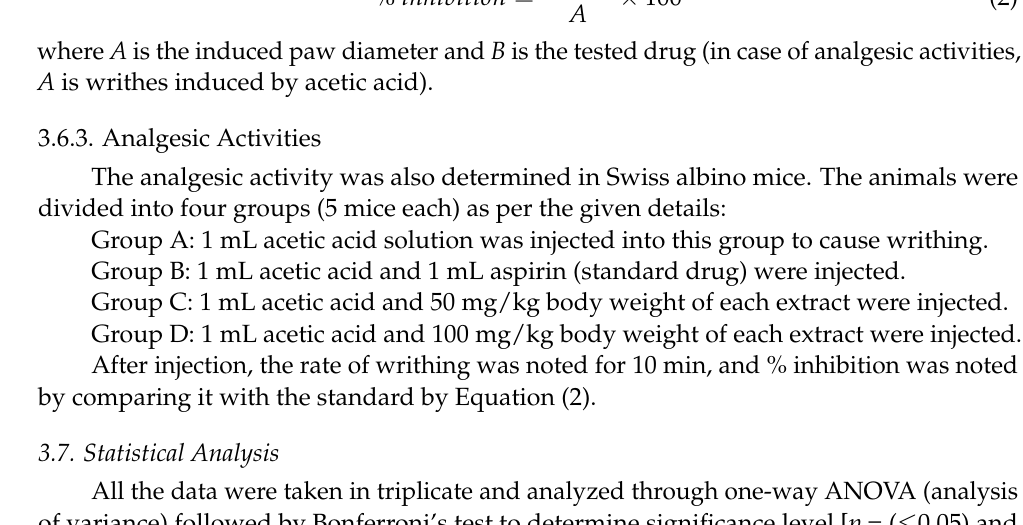
UA, Figure S2: 13 C-NMR of compound UA, Figure S3: ESI-HRMS of UA, Figure S4: 1 H-NMR of compound OV, Figure S5: 13 C-NMR of compound OV, Figure S6: ESI-HRMS of OV, Figure S7: 1 H- NMR of compound OA, Figure S8: 13 C-NMR of compound OA, Figure S9: ESI-HRMS of OA, Figure S10: 1 H-NMR of compound BS, Figure S11: 13 C-NMR of compound BS, Figure S12: ESI-HRMS of BS, Figure S13: 1 H-NMR of compound MA, Figure S14: 13 C-NMR of compound MA, Figure S15: ESI-HRMS of MA , Figure S16: 1 H-NMR of compound TA, Figure S17: 13 C-NMR of compound